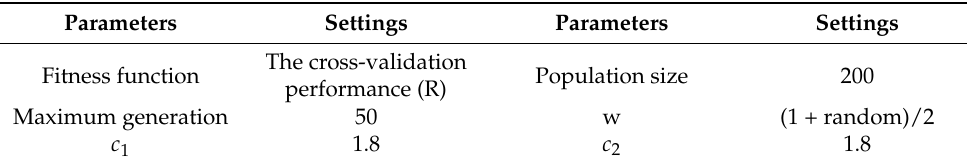
Table 2. PSO parameters employed in this